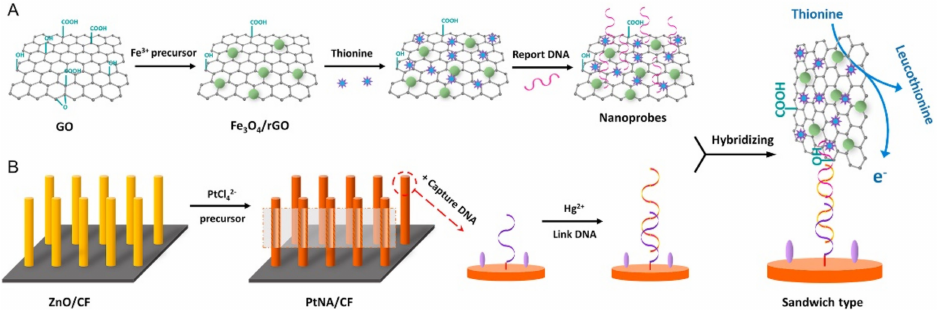
Figure 7. Schematic illustration of the assembly process and the detection strategy; ( A ) Preparation of nano-probe; ( B ) Modification of flexible electrode. Reprinted with permission from ref. [83]. Copyright 2018